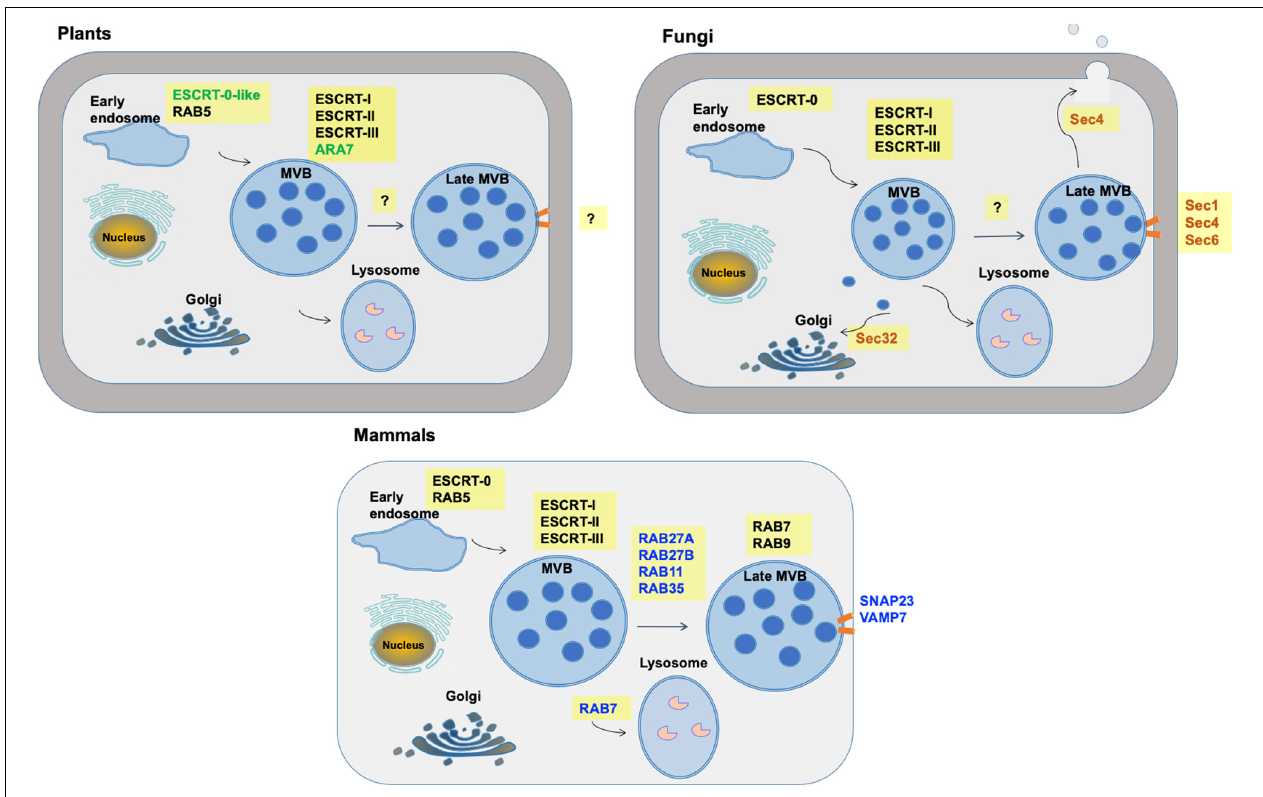
FIGURE 3 | Multivesicular body pathways of exosome formation and release in mammals, plants and fungi. Commonalities, differences and unknowns are shown in the machinery by which exosomes are formed via multivesicular bodies (MVBs). Machinery which differs is indicated with colored text. Orange bars indicate fusion of MVBs with the plasma membrane. “?” indicates machinery that has not yet been well